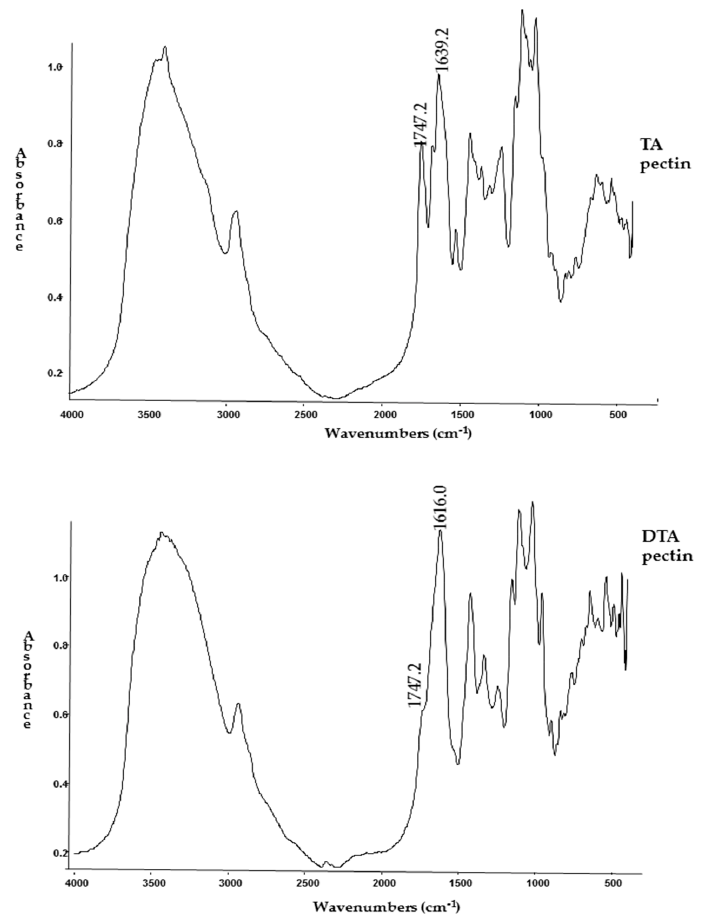
Figure 2. FT-IR absorption spectra for TA (untreated) pectin and deesterified (DTA) pectin (post treatment). The decrease in area of band absorbing at 1750 cm − 1 on DTA pectin spectrum compared to TA pectin band absorbing at 1750 cm − 1 evidence the decrease in esterified groups.